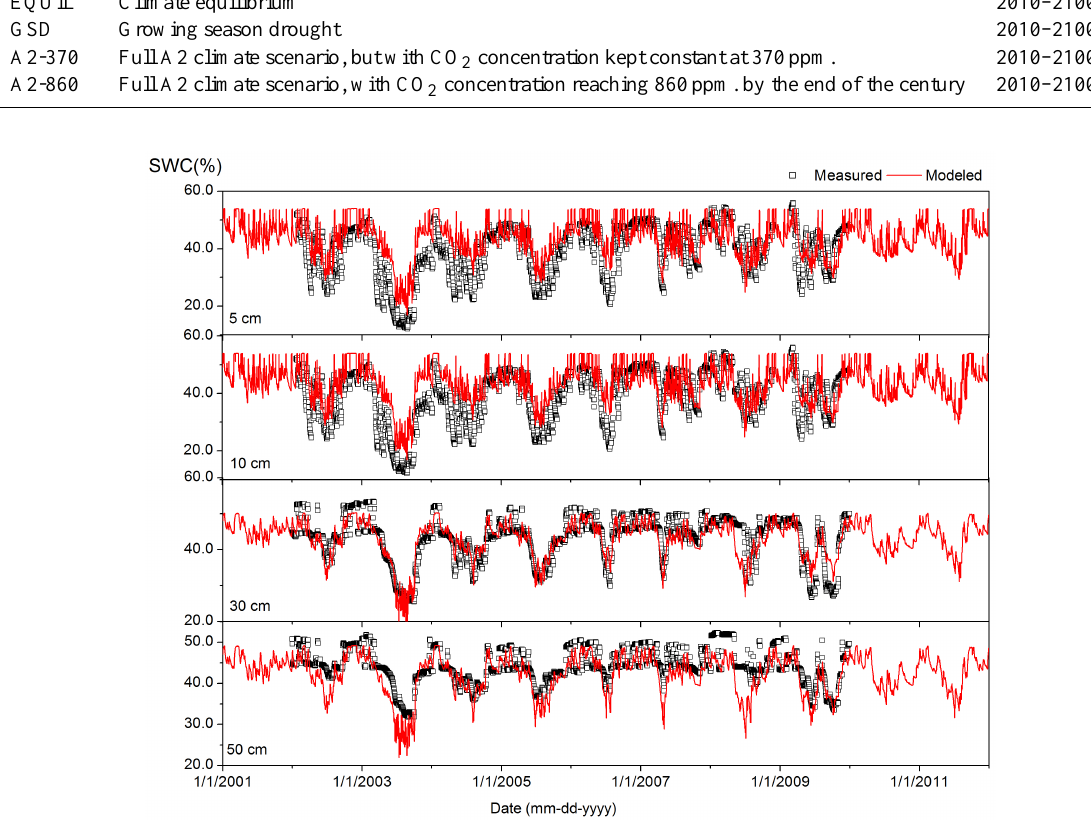
Fig. 2. Soil water content (SWC) expressed in %VOL in increasing soil